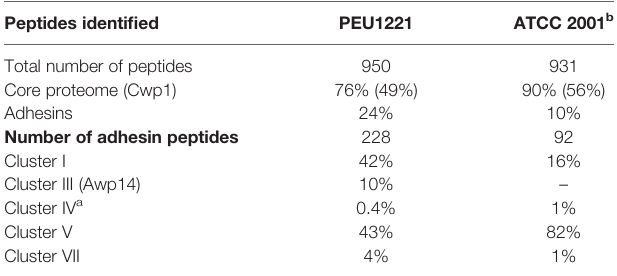
TABLE 2 | Semi-quantitative peptide-counting analysis of PEU1221 and ATCC 2001 cell wall proteomics data.